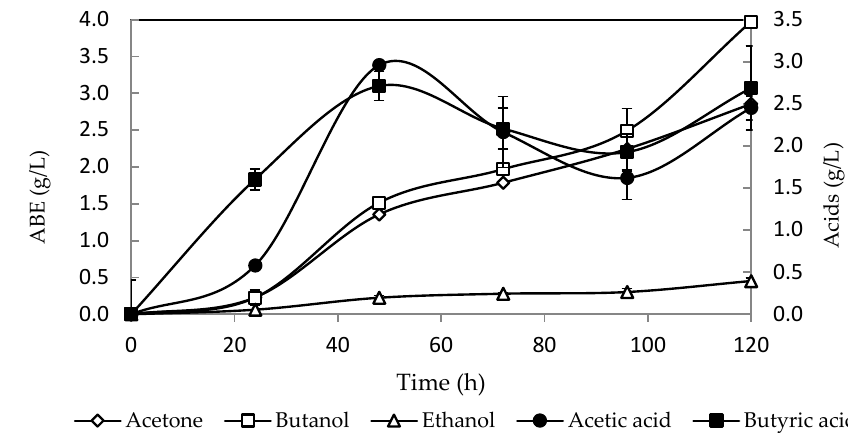
Figure 2. Simultaneous saccharification and fermentation (SSF) for biobutanol using oil palm empty fruit bunch by Clostridium acetobutylicum ATCC 824 at 35 °C, initial pH 5.5, cellulase loading of 15 FPU/g-substrate and 5% ( w / v ) oil palm empty fruit bunch (OPEFB) fibres. ( a ) The time courses for reducing sugar in SSF and SO and pH in the SSF system and ( b ) The ABE and acids concentration obtained from SSF process.